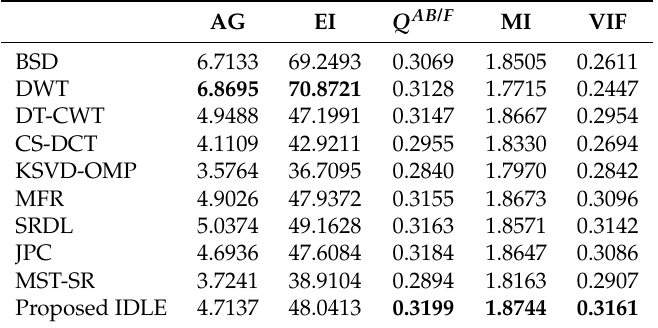
Table 2. Objective Evaluations of MRI-PET Image Fusion Comparative Experiments.